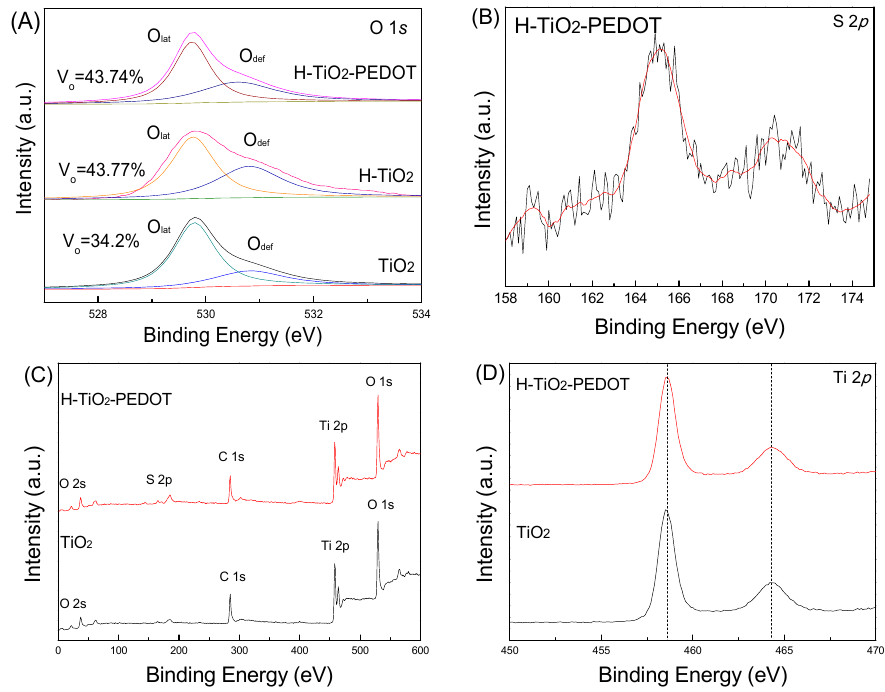
Figure 4. High-resolution XPS spectra of O 1s ( A ) and S 2p ( B ) of the TiO 2 , H-TiO 2 and H-TiO 2 -PEDOT. XPS survey spectra ( C ), high-resolution XPS spectra of Ti 2p ( D ) of the TiO 2 and H-TiO 2 -PEDOT.